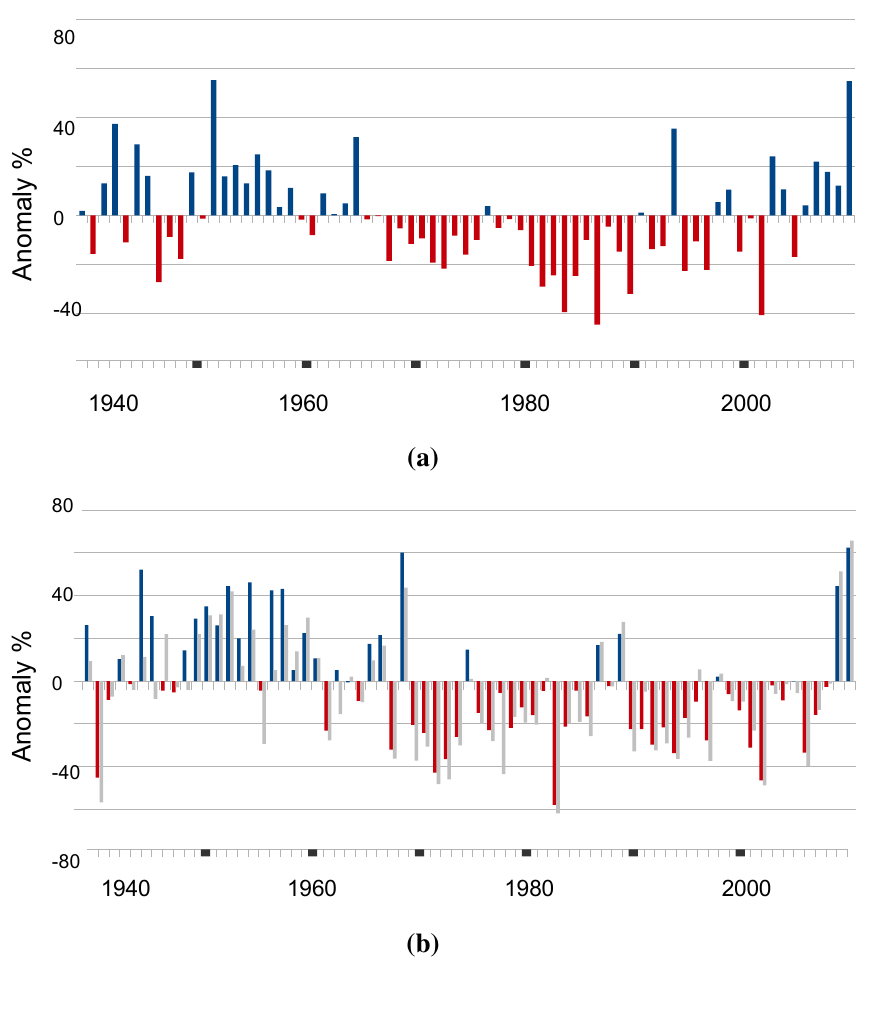
Figure 3. GPCC annual rainfall anomalies in percent for the period 1940–2010 averaged over the study areas of ( a ) Mali and ( b ) Senegal. Lingu`ere weather-station data is included in (b), indicating that gridded GPCC data corresponds well with ground-measured station data (grey columns). Note the extraordinary dry period in the 1970s and 1980s. Data after Schneider et al.